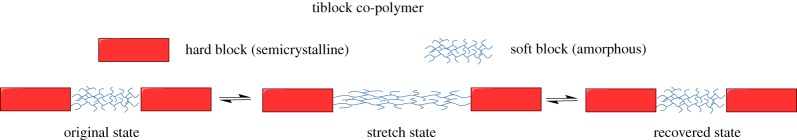
Elastic behaviour of α-olefin-based block copolymers.